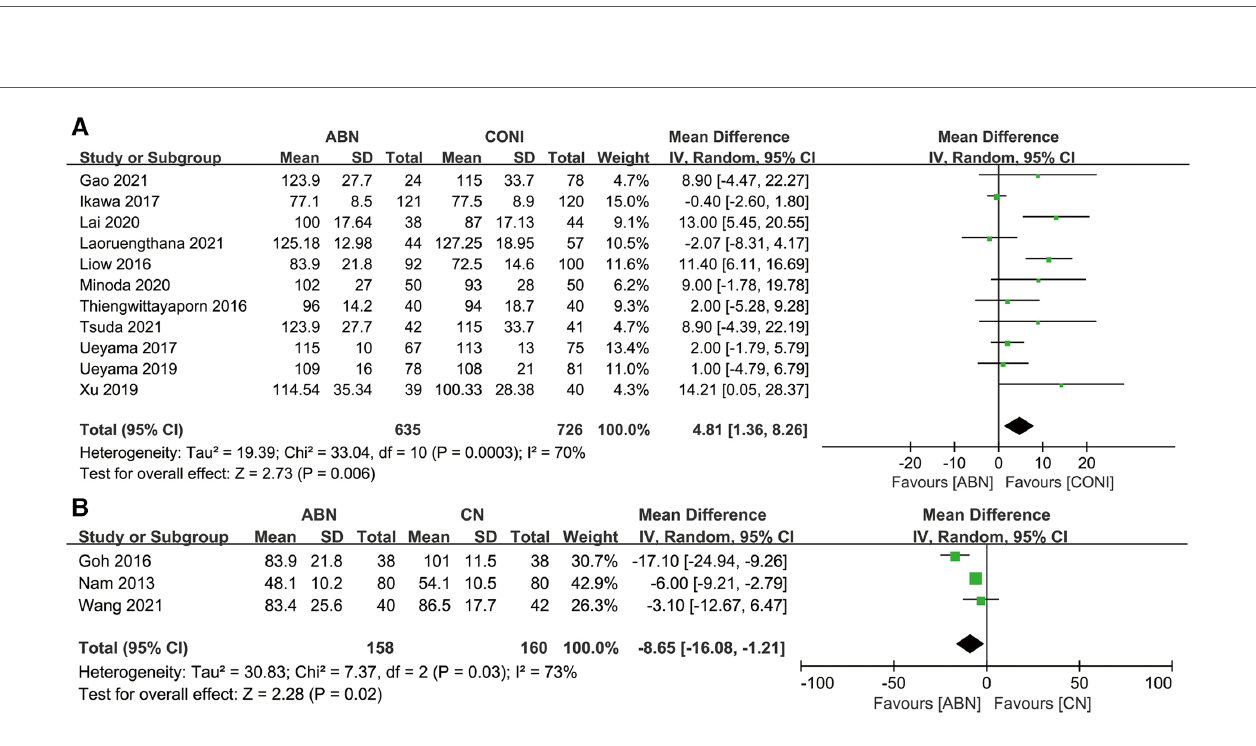
FIGURE 12 ( A ) Forest plot of surgical duration A: accelerometer-based navigation (ABN) system vs. conventional instrumentation (CONI); ( B ) ABN system vs. computer navigation (CN)